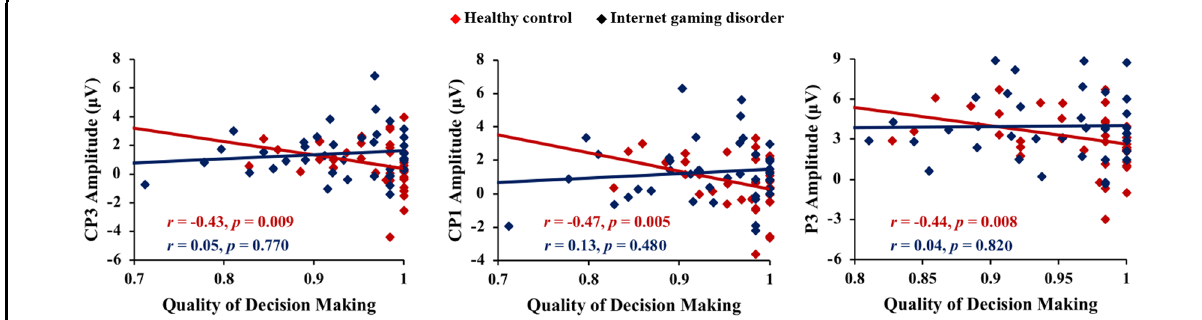
Fig. 3 The scatter plot demonstrates the relationship between the quality of decision-making in the Cambridge Gambling Task and LPP elicited by game-related cue in the Internet gaming disorder group and the healthy control group. This correlation was observed signi fi cantly only in the healthy control